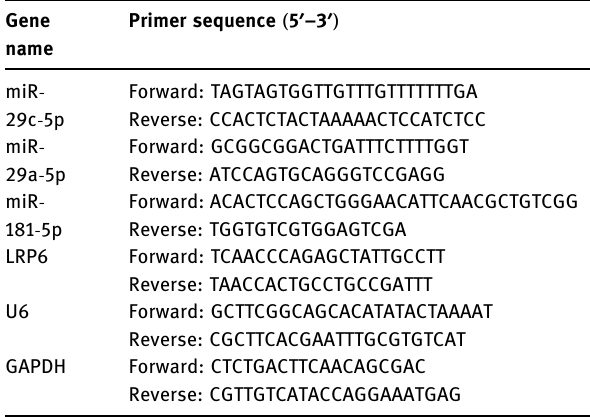
Table 1: The sequences of all primers used in qRT -